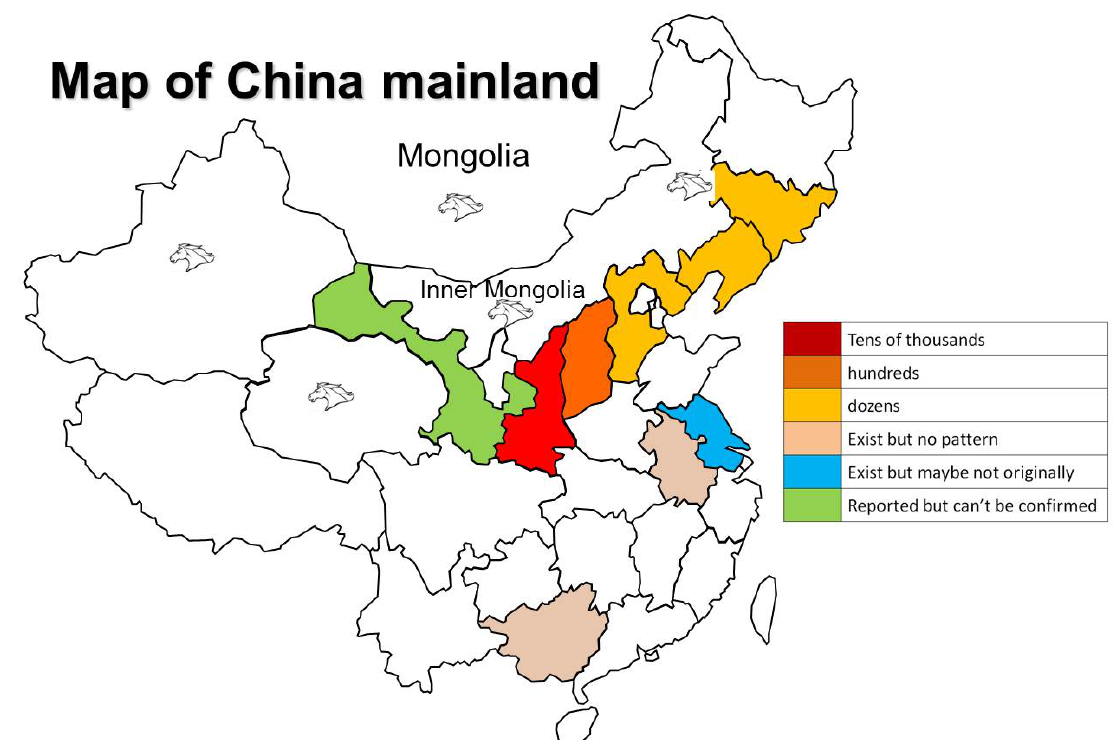
Figure 2. Distribution of horse hitching stone posts in the Chinese